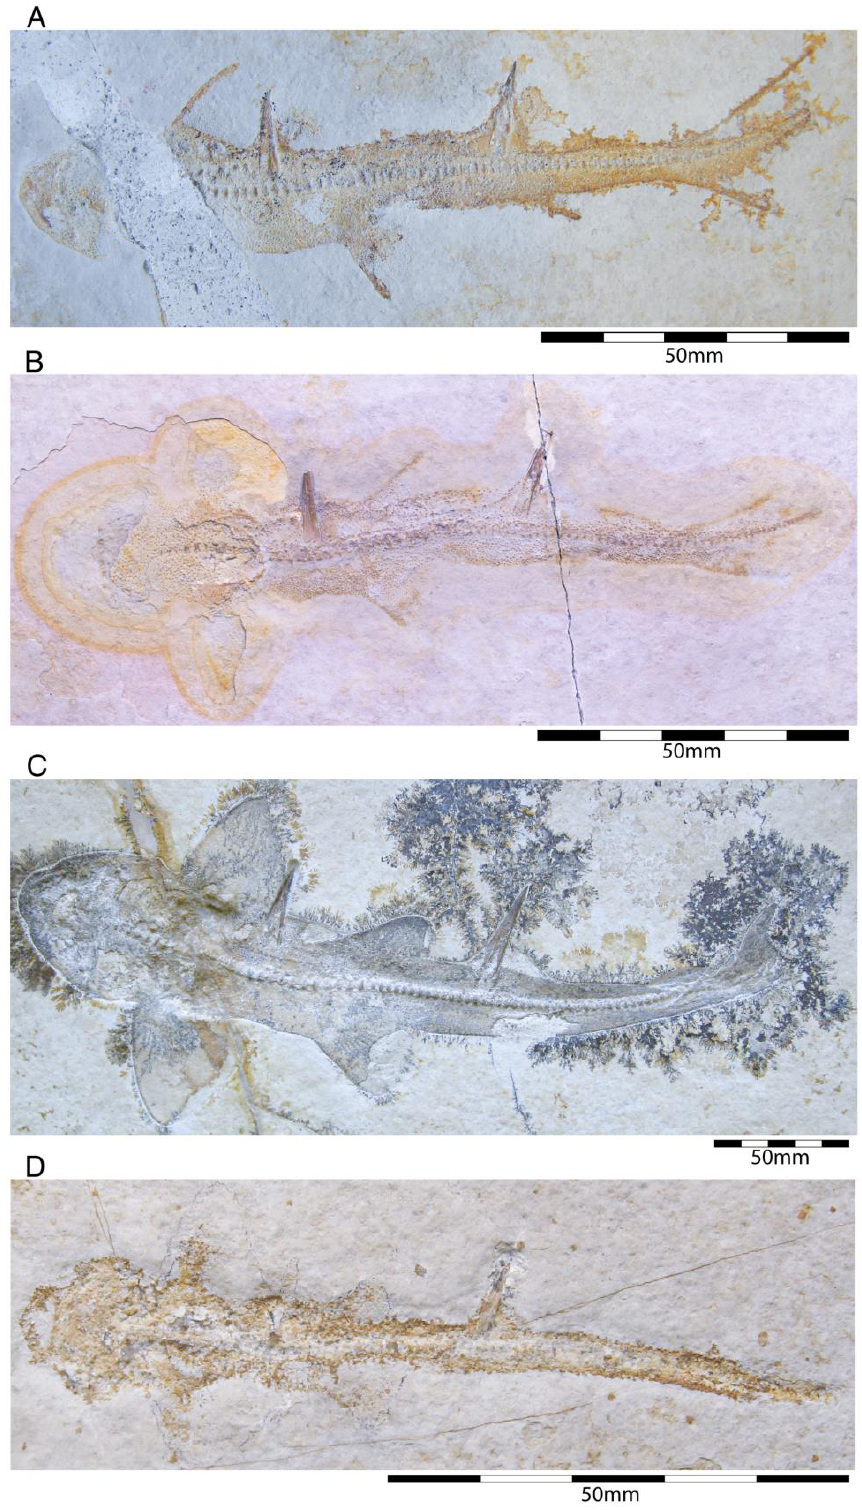
Figure 20. † Heterodontus zitteli Eastman, 1911 [219]. ( A ) Holotype specimen (NHMUK P 6938) from the Kimmeridgian of Eichstätt. ( B ) Holomorphic specimen (SNSB-BSPG 1885 I 12a) from the Tithonian of Eichstätt. ( C ) Holomorphic specimen (JME SOS 3577) from the lower Tithonian between Wintershof and Workerszell. ( D ) Holomorphic specimen (JME SOS 3153) from the lower Tithonian from Blumenberg.